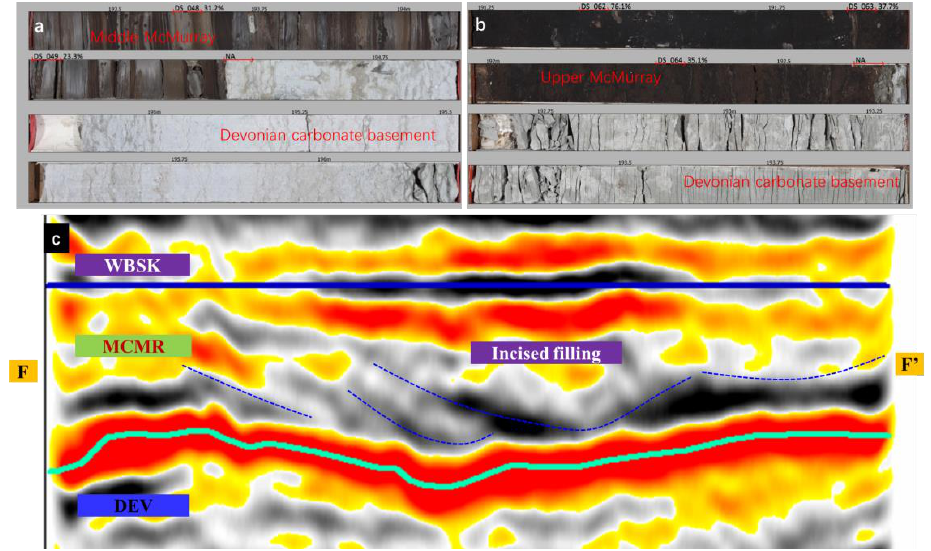
Figure 9. ( a ) Middle McMurray was deposited in contact with carbonate basement; ( b ) Upper McMurray was deposited in contact with carbonate basement; ( c ) 2D seismic section in cross-section. (The section location FF’ is shown in Figure 1).